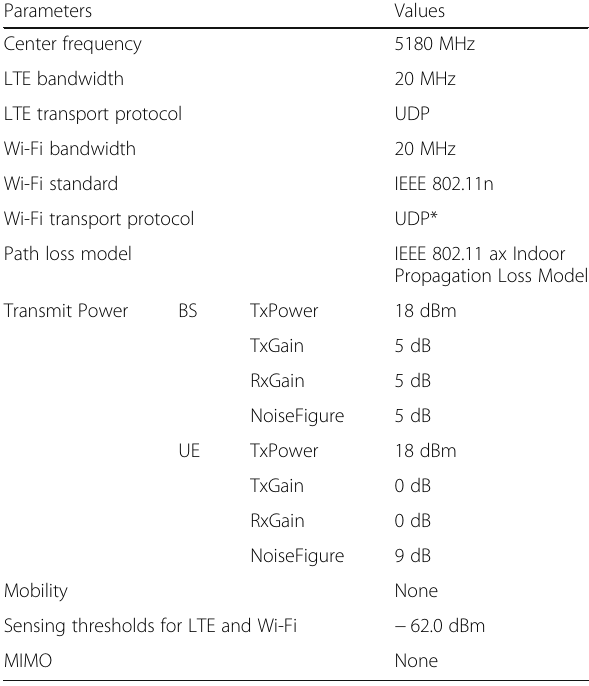
Table 1 Basic LTE/WI-FI system model